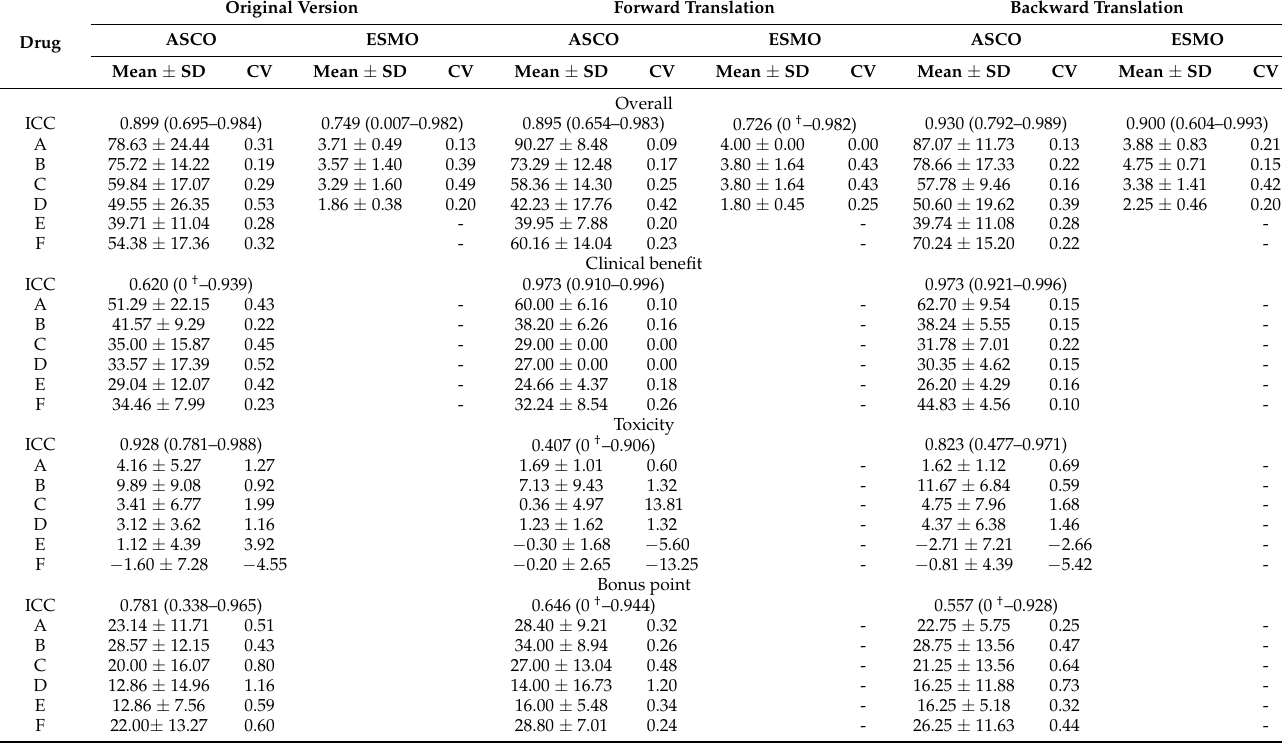
Table 1. Validation scores for six drugs.